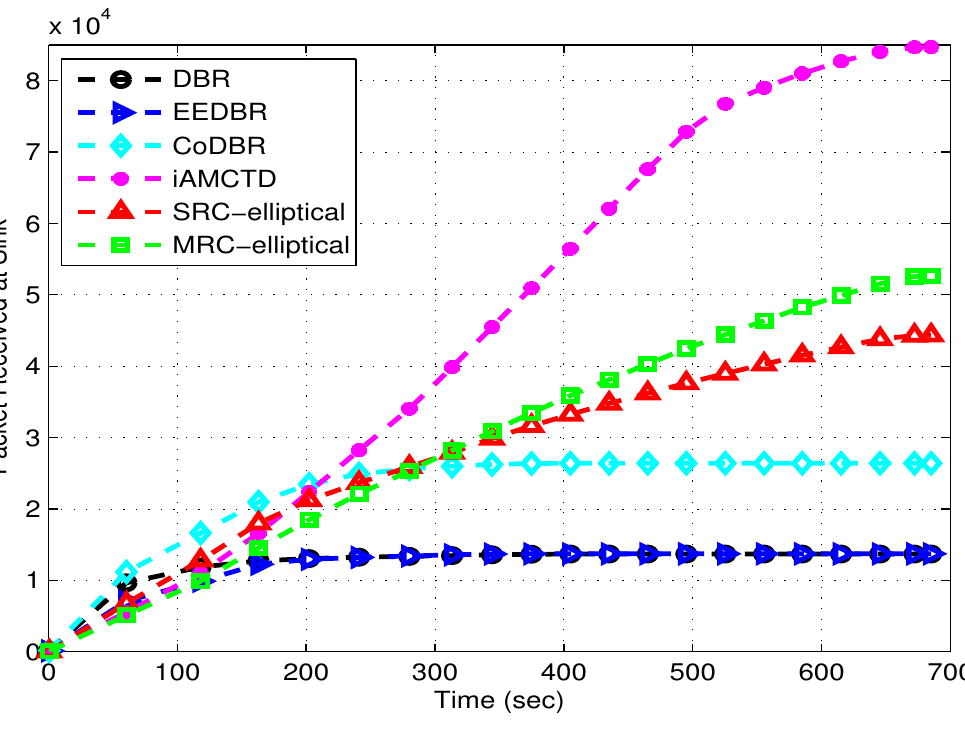
( b ) Elliptical sink mobility patterns.